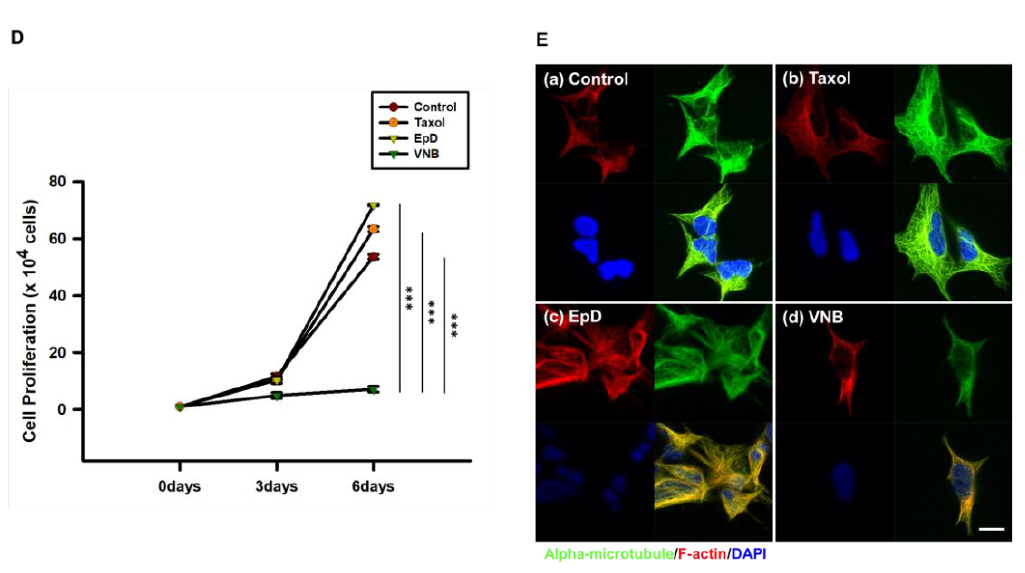
Figure 1. Microscope images, viability, and proliferation of microtubule stabilizer- and microtubule disturber-treated cells. ( A ) Light microscope imaging of cells treated with Taxol, EpD, and VNB. ( a ) Image of 20 × ; ( b ) image of 40 × ; ( B ) graph of cell size following treatment with Taxol, EpD, and VNB. ( C ) Graph of cell viability following treatment with Taxol, EpD, and VNB. ( D ) Graph of cell proliferation at 3 and 6 days after treatment with Taxol, EpD, and VNB. ( E ) Confocal images of microtubules and F-actin in ( a ) control, ( b ) Taxol-treated, ( c ) EpD-treated, and ( d ) VNB-treated cells. Scale bar = 20 μm. The data are presented as means ± SEM of three replicates. Significant differences are indicated by asterisks (* p < 0.05, ** p < 0.01, *** p < 0.001.). Statistical significance was determined by a one-way ANOVA.